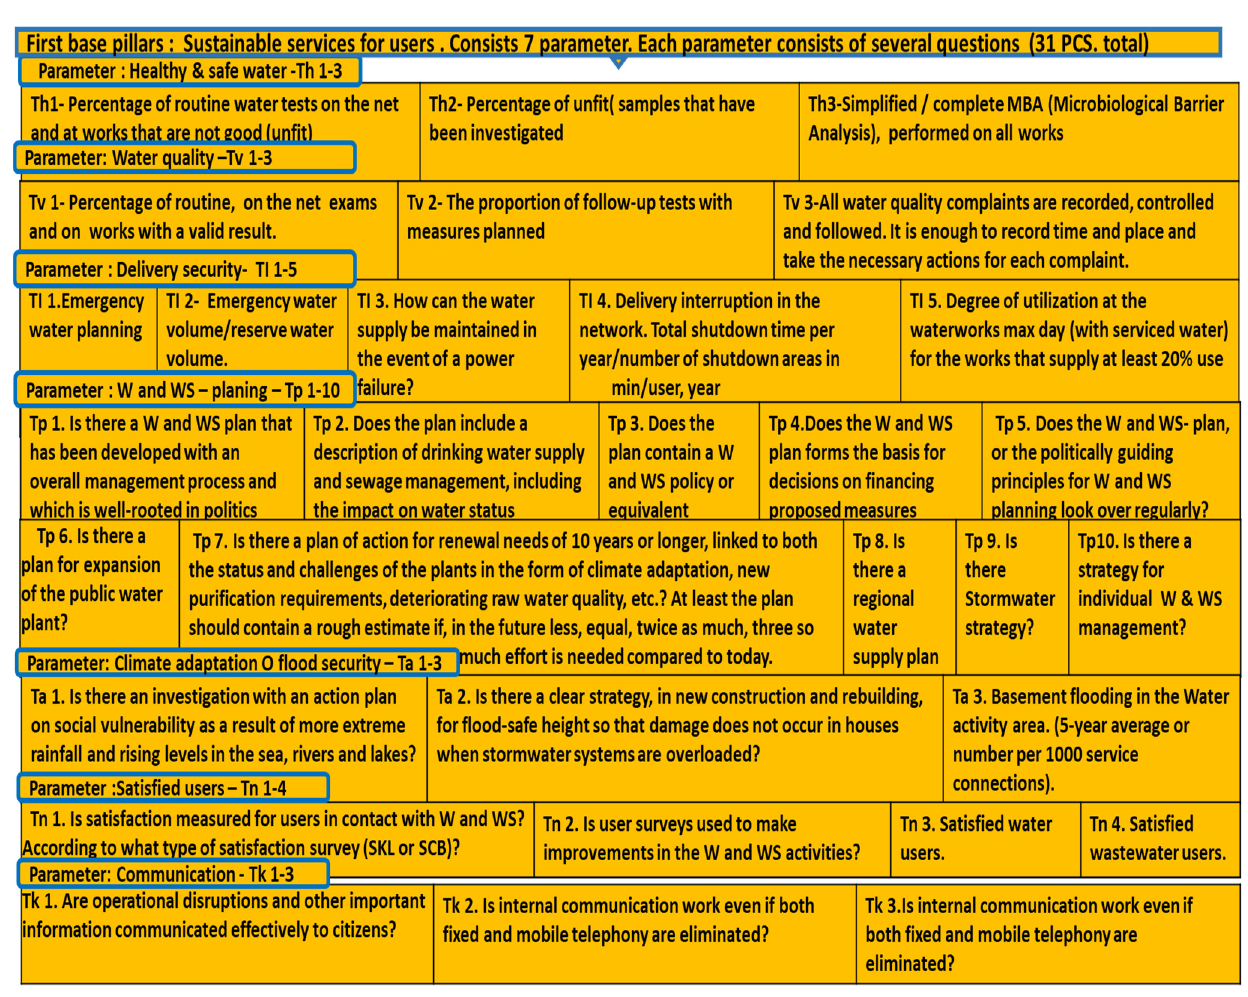
Figure A1. “Sustainable services for users” pillar, seven related parameters, group codes for parameters, and related questions (key figures).